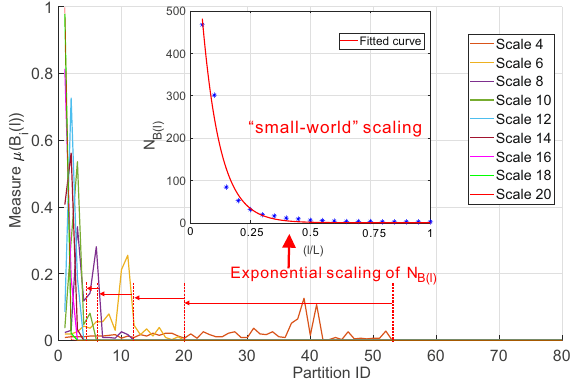
Figure 17. The fundamental impact of link weights on the multi-fractality of Budapest connectome network. Figure shows the similar loss of multi-fractality by removing the weights on the links of Budapest connectome. The scaling behavior is best explained by an exponential law ( a * exp ( bx ), a = 934.7, b = − 0.664) indicating that the common brain connectome is a “small-world” if no weights are